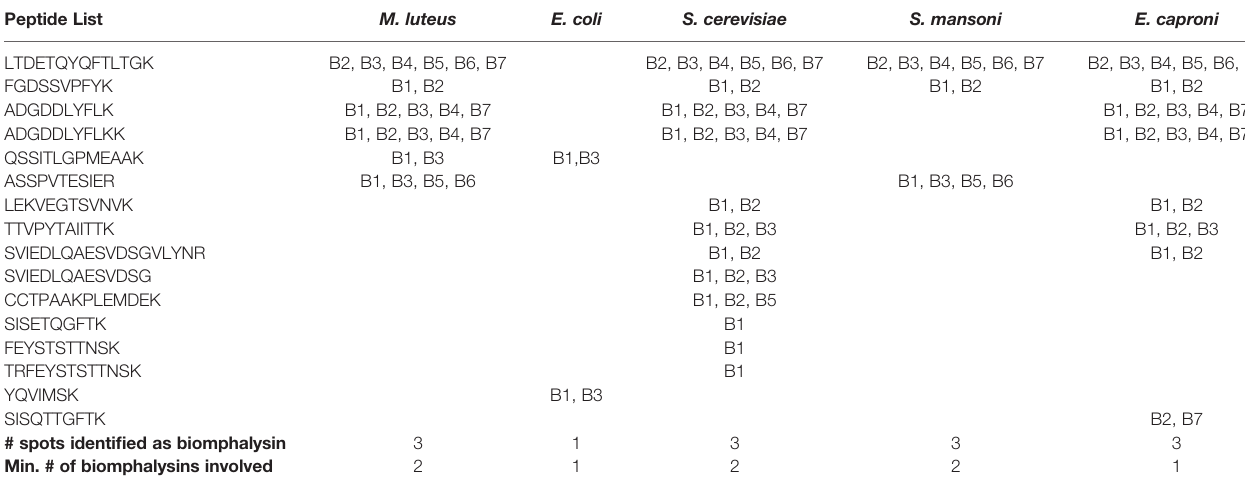
Peptide List M. luteus E.